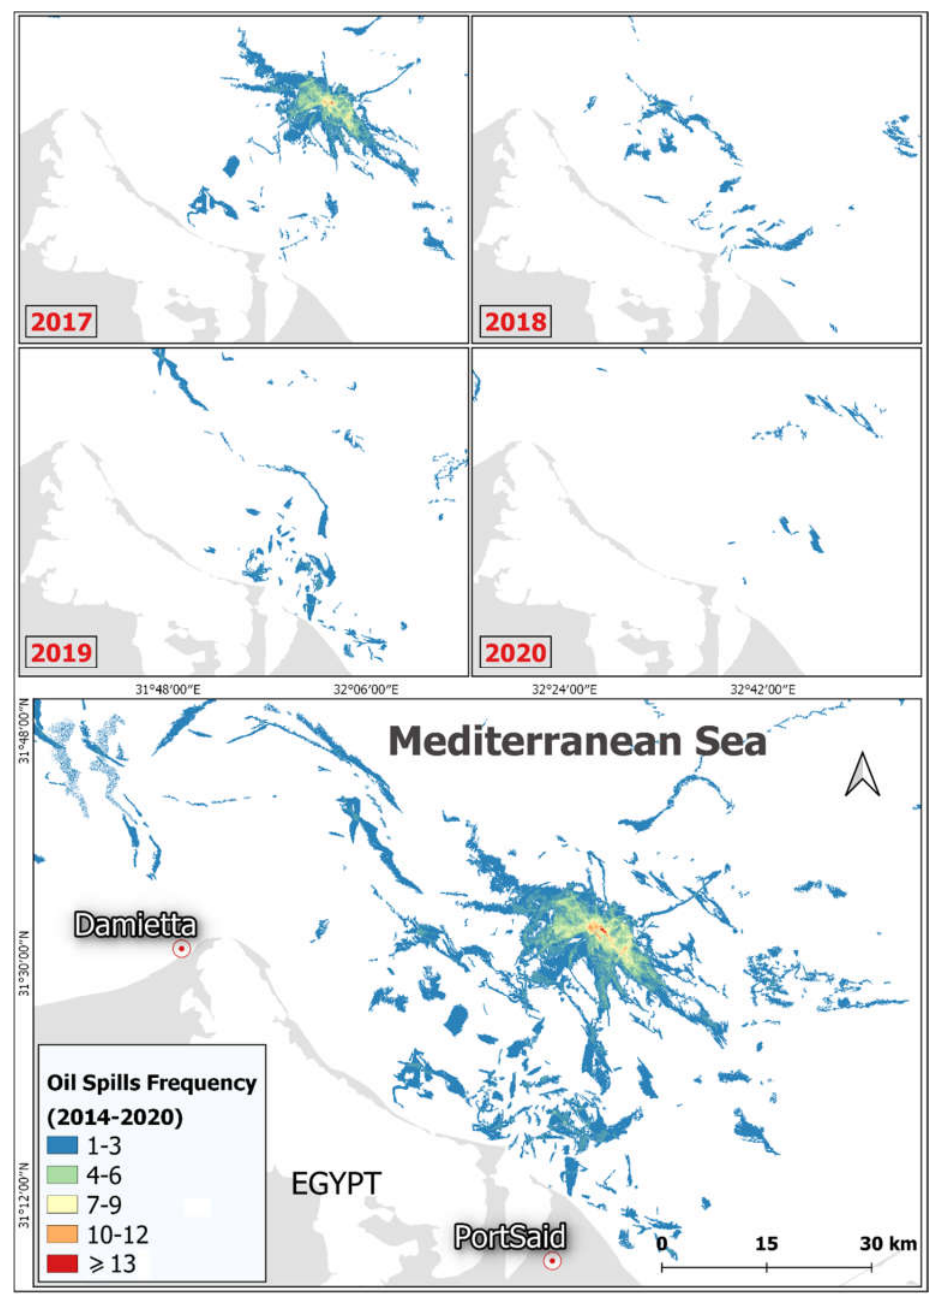
Figure 9. Frequency of oil spills cases on locational dimension near Port Said on a yearly basis that shows the majority of oil spill cases are near Port Said between 2017 and